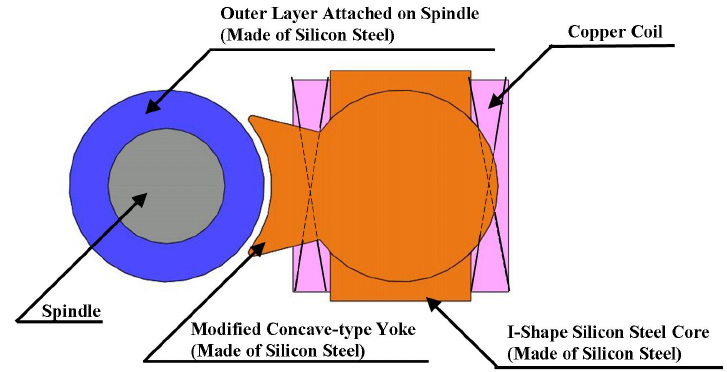
Figure 3. Top view of the ECAMA and spindle.